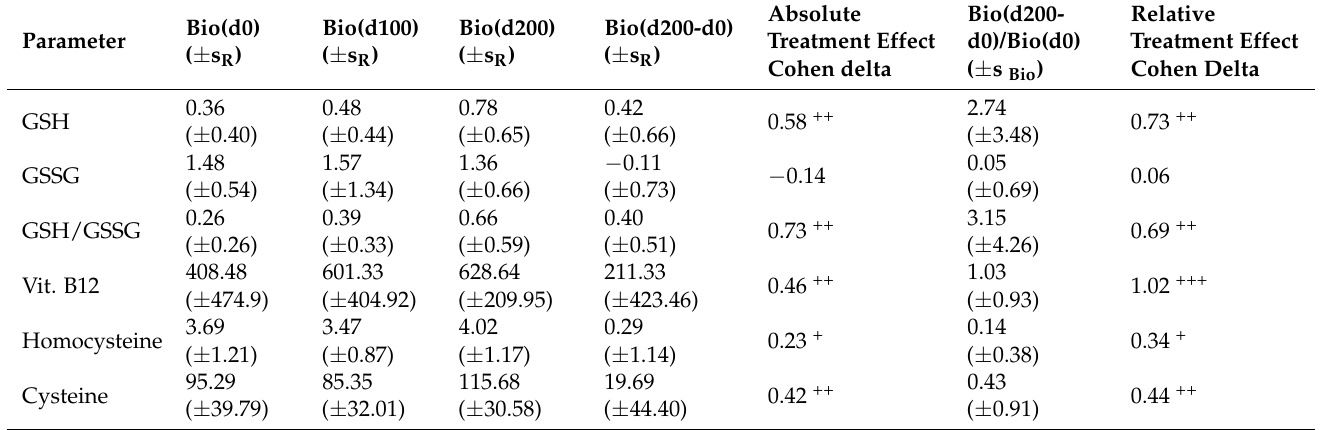
Table 2. Biochemistry parameters of the treatment group (Bio) during the study (d0—before the treatment, d100—at day 100 of treatment, d200- at day 200 of treatment), and the evaluation of the overall absolute and relative changes (d200 vs. d0 values) explained by Cohen